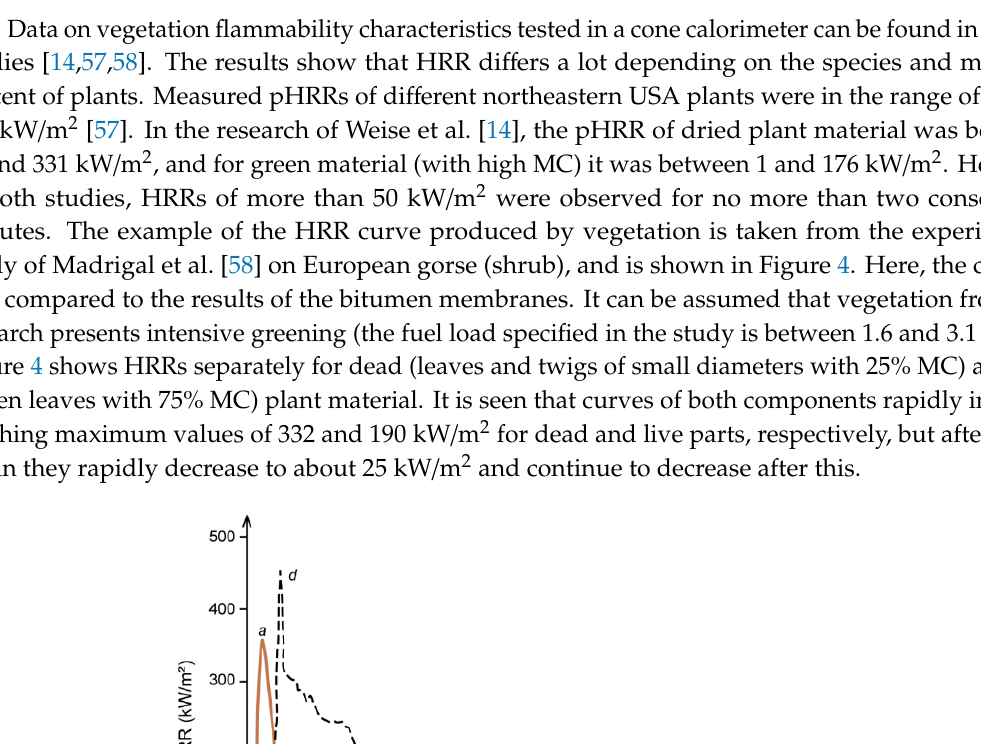
Table 5. Times to ignition (seconds) and flameout for dry and moist substrates. 0% MC 30% MC Ignition Flameout Ignition Flameout Sample s s s s Substrate 1 5 560 462 686 Substrate 2 7 294 − 1 1 no ignition and flameout observed.